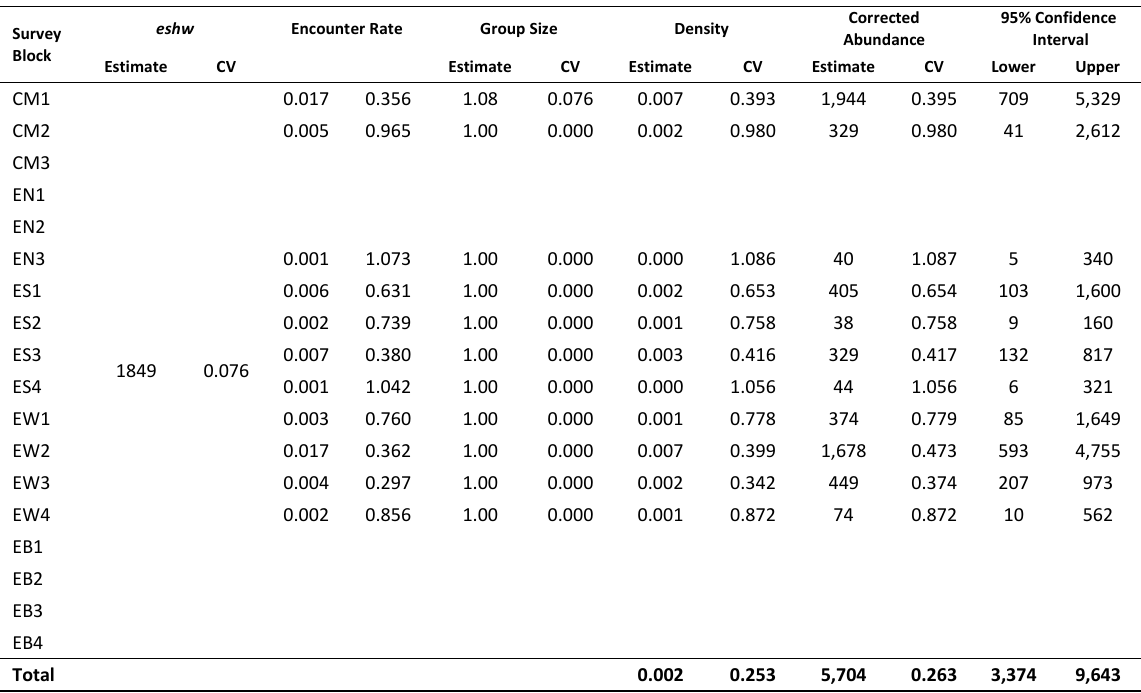
Table 8. Estimated density and abundance of sperm whales. The eshw (effective search half width (m)) was estimated for the entire study area. Encounter rate, group size, density, abundance, and upper and lower confidence limits were estimated by block and corrected for perception bias, with the estimated p